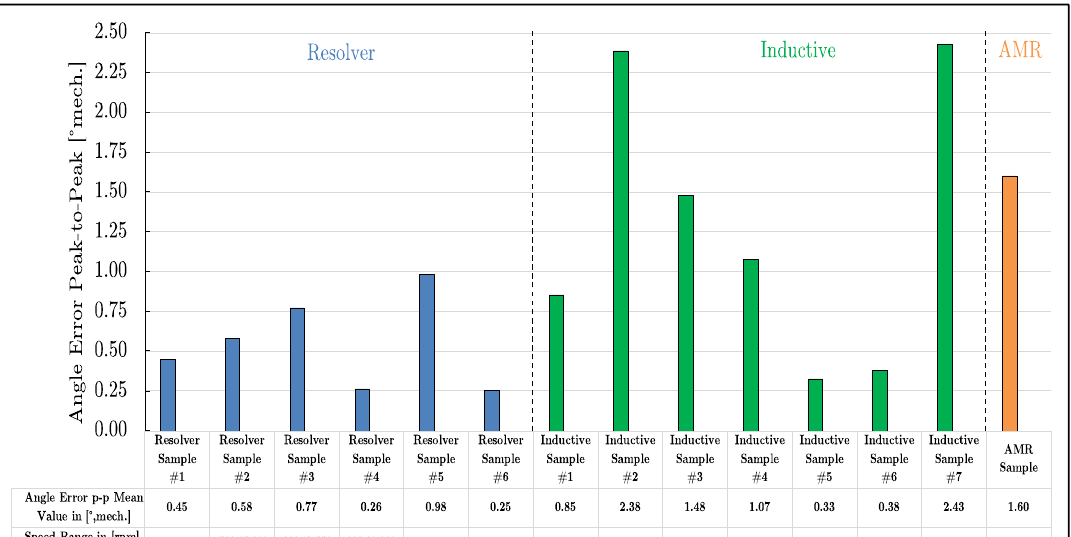
Figure 16. Experimental comparison of the resolver-, inductive- and AMR-position sensor technology, based on a variable applied speed and both constant temperature ( T = 25 °C = RT) and constant centric sensor placement.